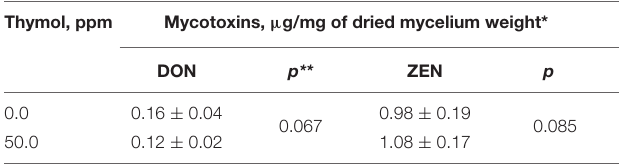
TABLE 6 | Deoxynivalenol (DON) and zearalenone (ZEN) production by a toxigenic F. culmorum strain cultured in thymol-containing Myro medium. Thymol, ppm Mycotoxins, µ g/mg of dried mycelium weight* DON